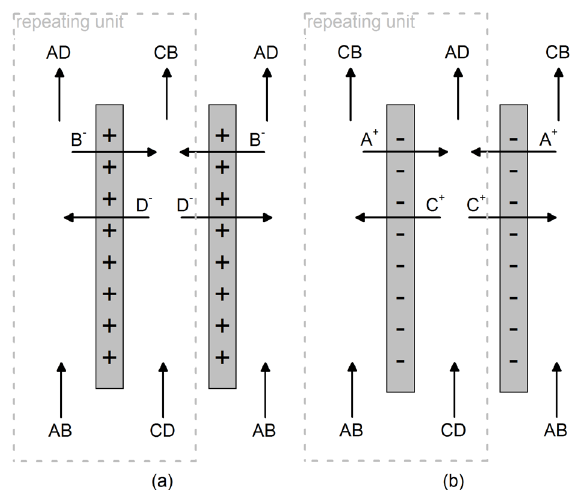
Figure 6: Schematic representation of Donnan